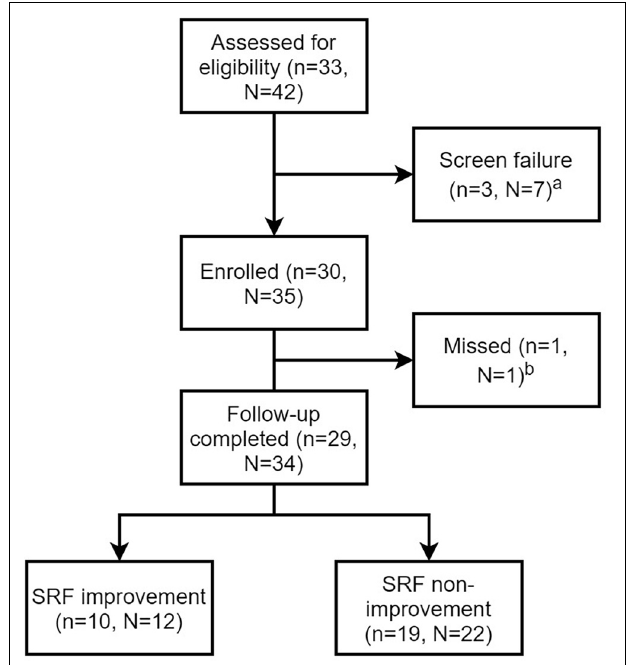
FIGURE 2 | Flow chart of patients and lesions. n stands for number of patients and N stands for number of renal artery lesions. a Screen failure was due to < 70% stenosis confirmed by angiography in three patients with unilateral renal artery stenosis and unsuccessful guidewire crossing in four patients with bilateral renal artery lesions. b The missing patient had 1-month follow-up, but didn’t complete the nuclear renal dynamic imaging.